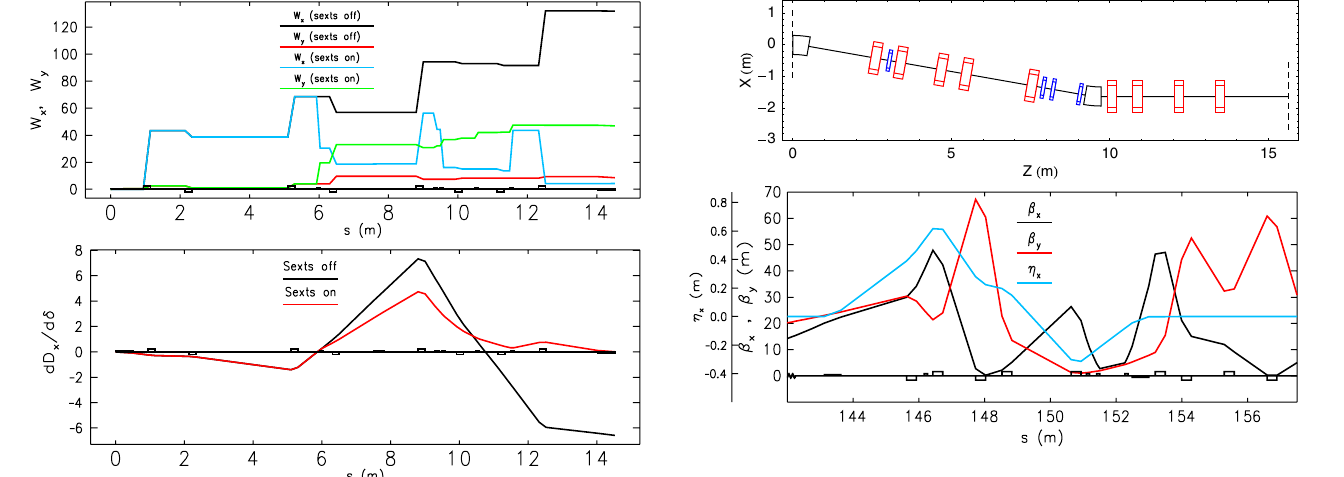
FIG. 4. Top: Floor layout of the linac-to-arc matching achro- mat, sextupoles shown in blue. Bottom: Optics and dispersion functions in linac-to-arc matching achromat.